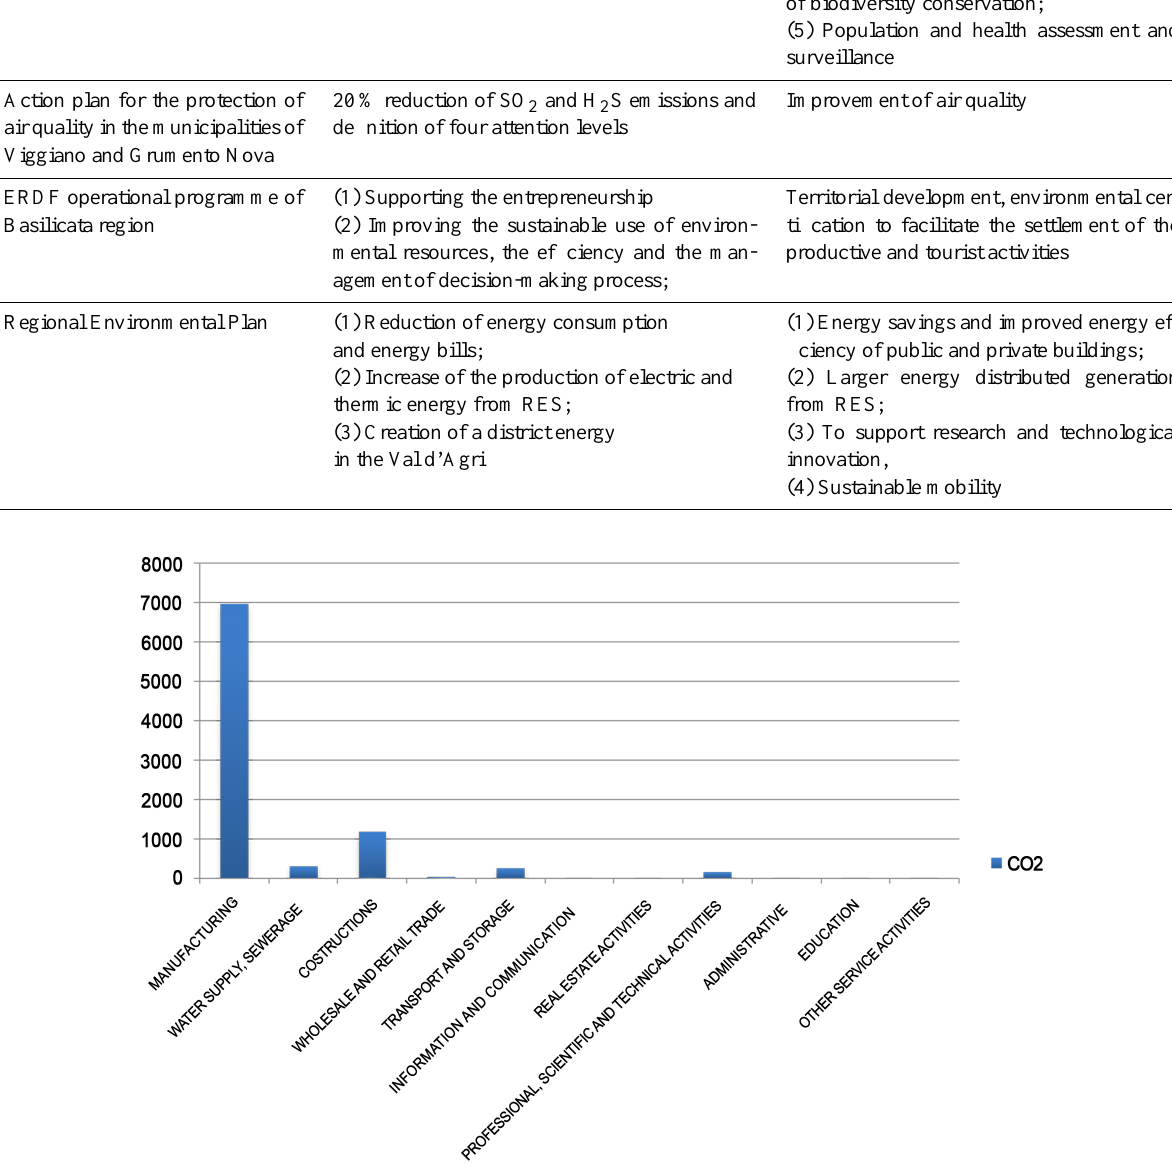
Figure 9. CO 2 emissions from energy processes by sector